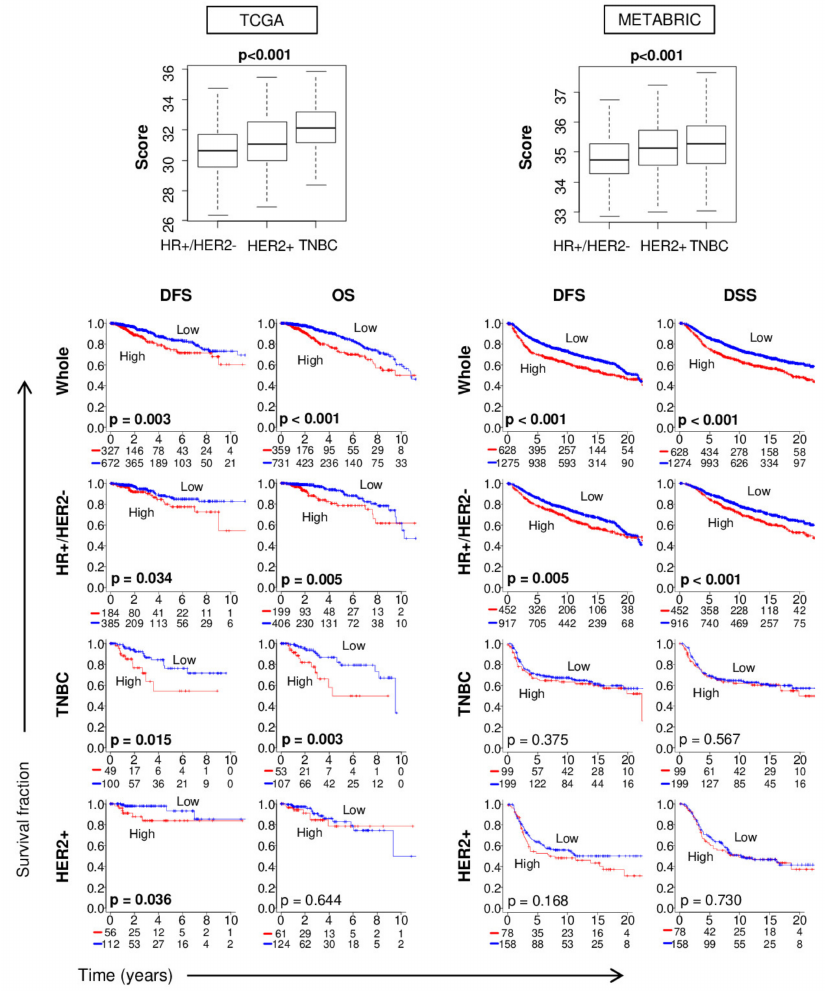
Figure 2. The 4-gene score is prognostic for disease-free survival (DFS) especially for hormonal receptor (HR) +/ human epidermal growth factor receptor 2 (HER2) cancer. At the top, boxplots show the association between the 4-gene score and cancer subtype. All boxplots are of Tukey type and boxes depict medians and inter-quartile ranges. p values were calculated with one-way ANOVA test. Below are Kaplan–Meier plots with logrank test p values for association between tumor 4-gene score and DFS and overall (OS) or disease-specific (DSS) survival for cancer of HR +/ HER2 − , HER2 + , and triple-negative (TNBC) subtypes. Within-group one-third percentile value of the 4-gene score was used to divide patients into low and high